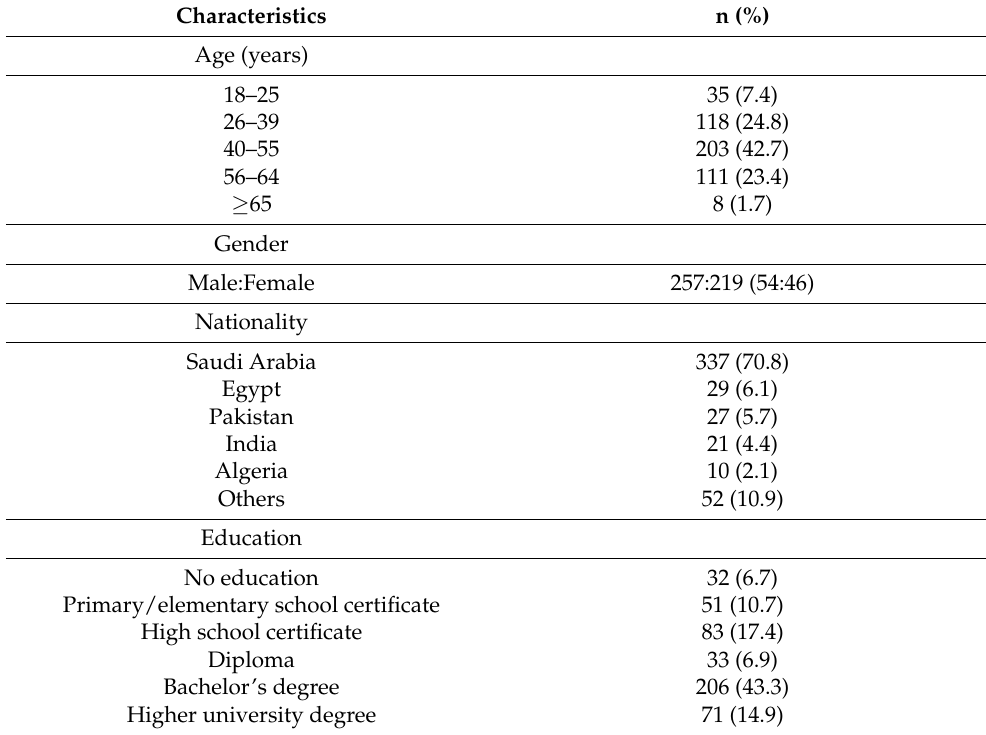
Table 1. Participants’ socio-demographic characteristics (n = 476).